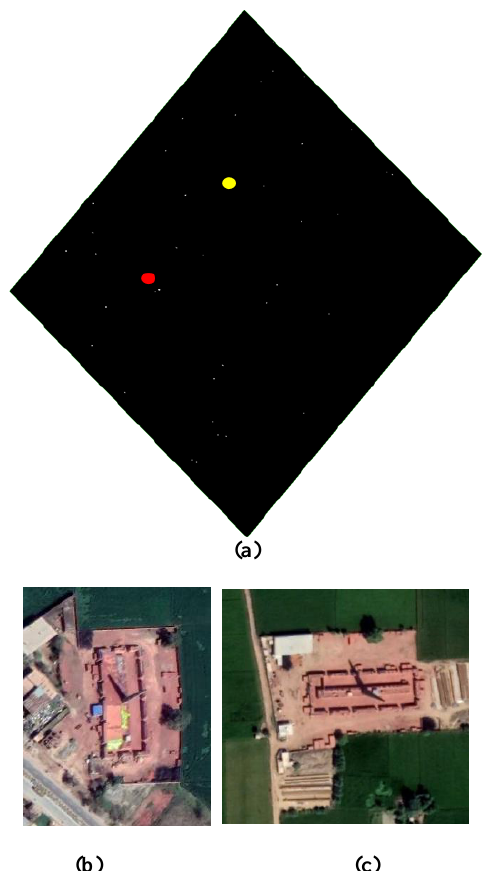
Figure 3: (a) Target map of brick kilns, HR image of the (b) Red and (c) Yellow marked locations respectively showing true ppositive detections.